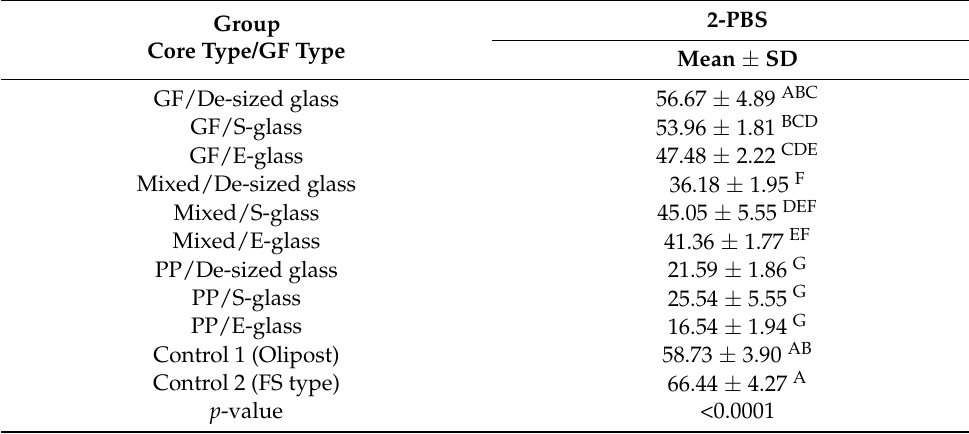
Table 4. Means and standard deviations (SD) of two-point bending flexural strength (2-PBS) (MPa) for second